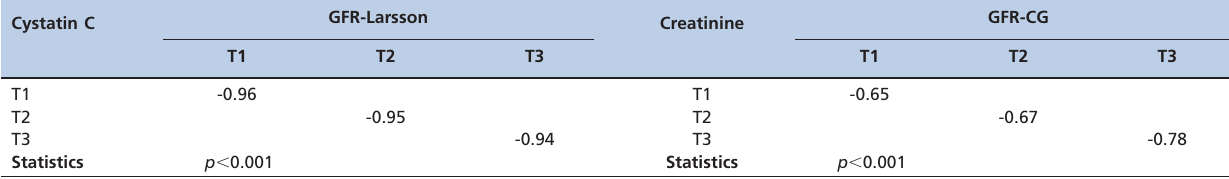
Table 2 - Pearson’s correlation between Cys C levels (mg.L -1 ), creatinine values (mg.dL -1 ), and the GFR (mL.min -1 ) at three different studied time points (average ¡ standard